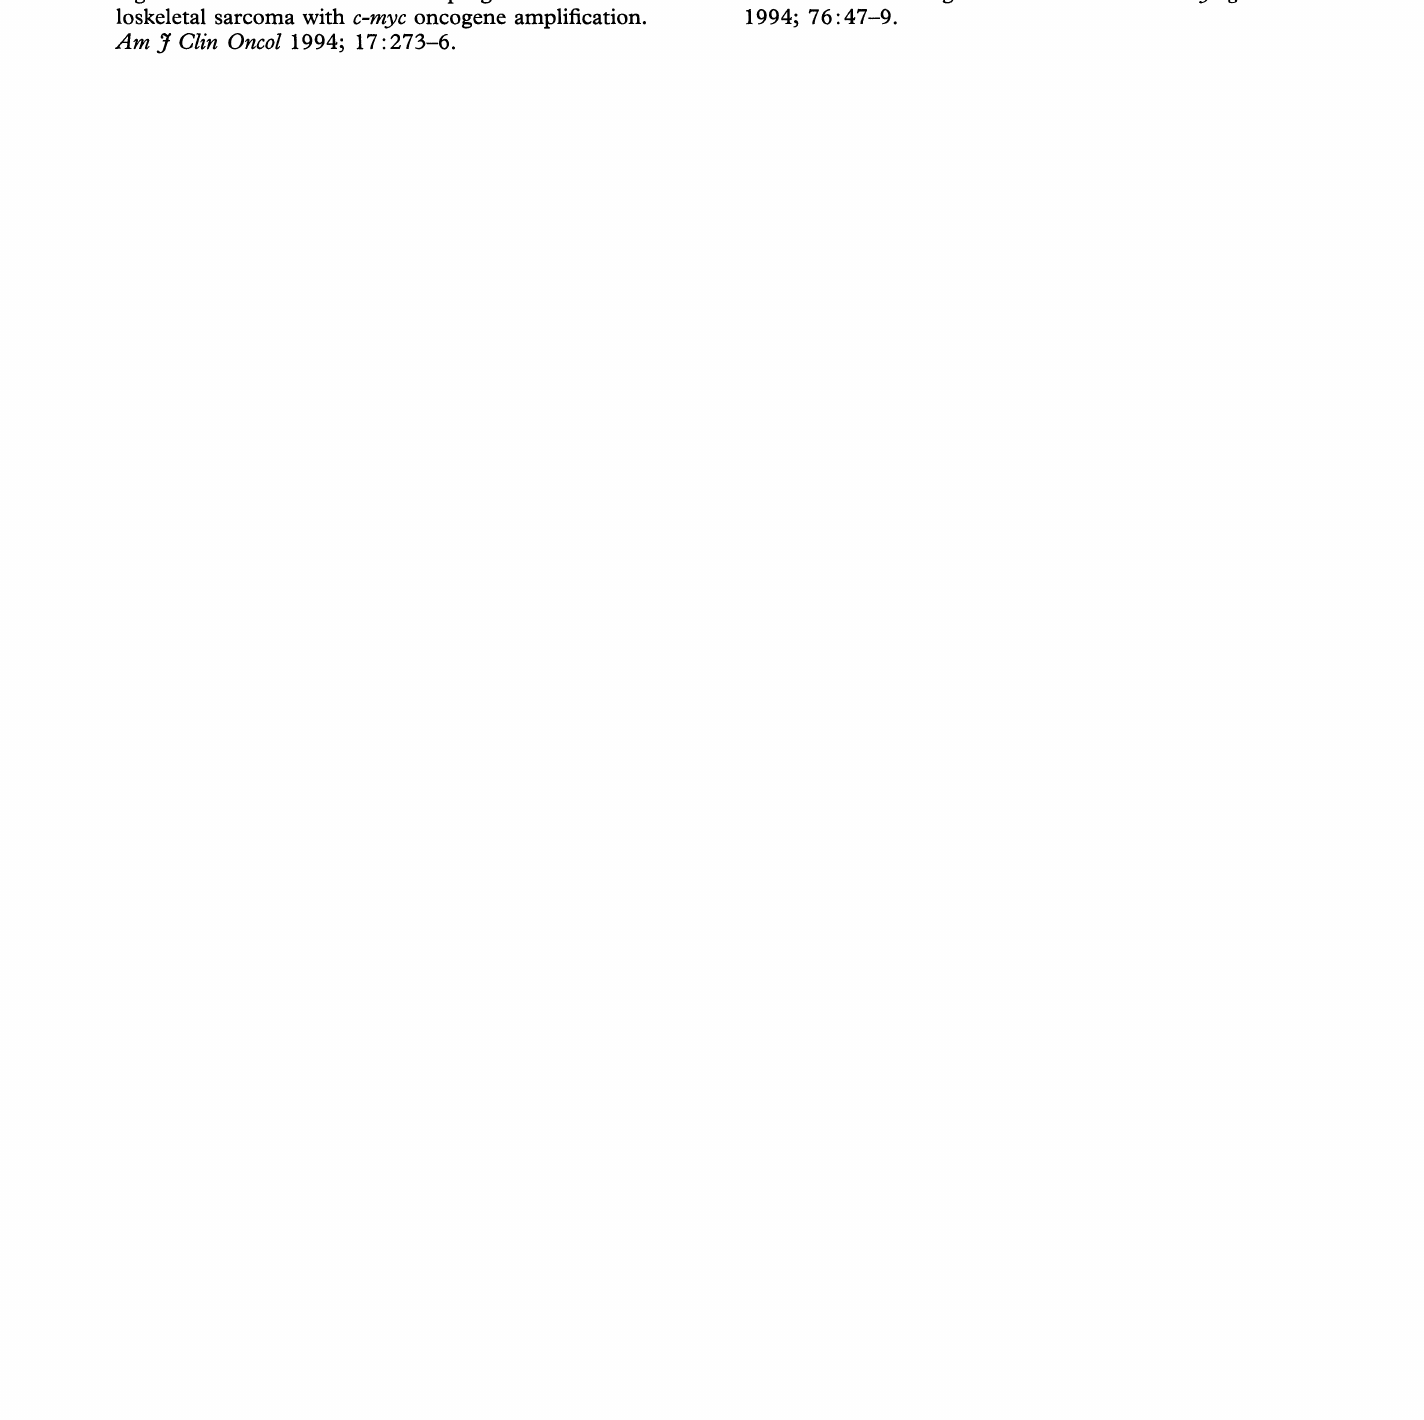
17 Perren TJ. C-erbB-2 oncogene as a prognostic marker in breast cancer. Br J Cancer 1991; 63:328-32. 18 Seeger RC, Brodeur GM, Sather H, et al. Association of multiple copies of the N-myc oncogene with rapid progression of neuroblastomas. N Engl J Med 1985; 313:1111-16. 19 Ozaki T, Ikeda S, Kawai A, et al. Alterations of retinoblastoma susceptibility gene accompanied by c- myc amplification in human bone and soft tissue tumors. Cell Mol Biol 1993; 39:235-42. 20 Bogenmann E, Moghadam H, DeClerck YA, et al. C-myc amplification and expression in newly estab- lished human osteosarcoma cell lines. Cancer Res 1987; 47:3808-14. 21 Kawai A, Ozaki T, Ikeda S, et al. Two distinct cell lines derived from a human osteosarcoma. J Cancer Res Clin Oncol 1989; 115 531-6. 22 Castresana JS, Barrios C, Gomez L, et al. No associ- ation between c-myc amplification and TP53 mutation in sarcoma tumorigenesis. Cancer Genet Cytogenet 1994; 76: